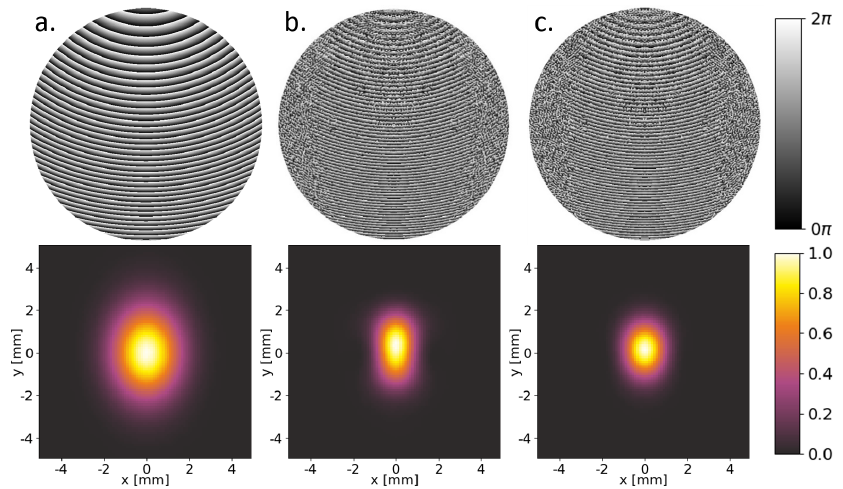
Figure 3. The comparison of the phase distributions ( top panels) and focal spots ( bottom panels) of the off-axis lens in the first three steps of the iterative algorithm for: (( a ). a single propagation, ( b ). the second iteration and ( c ). the third